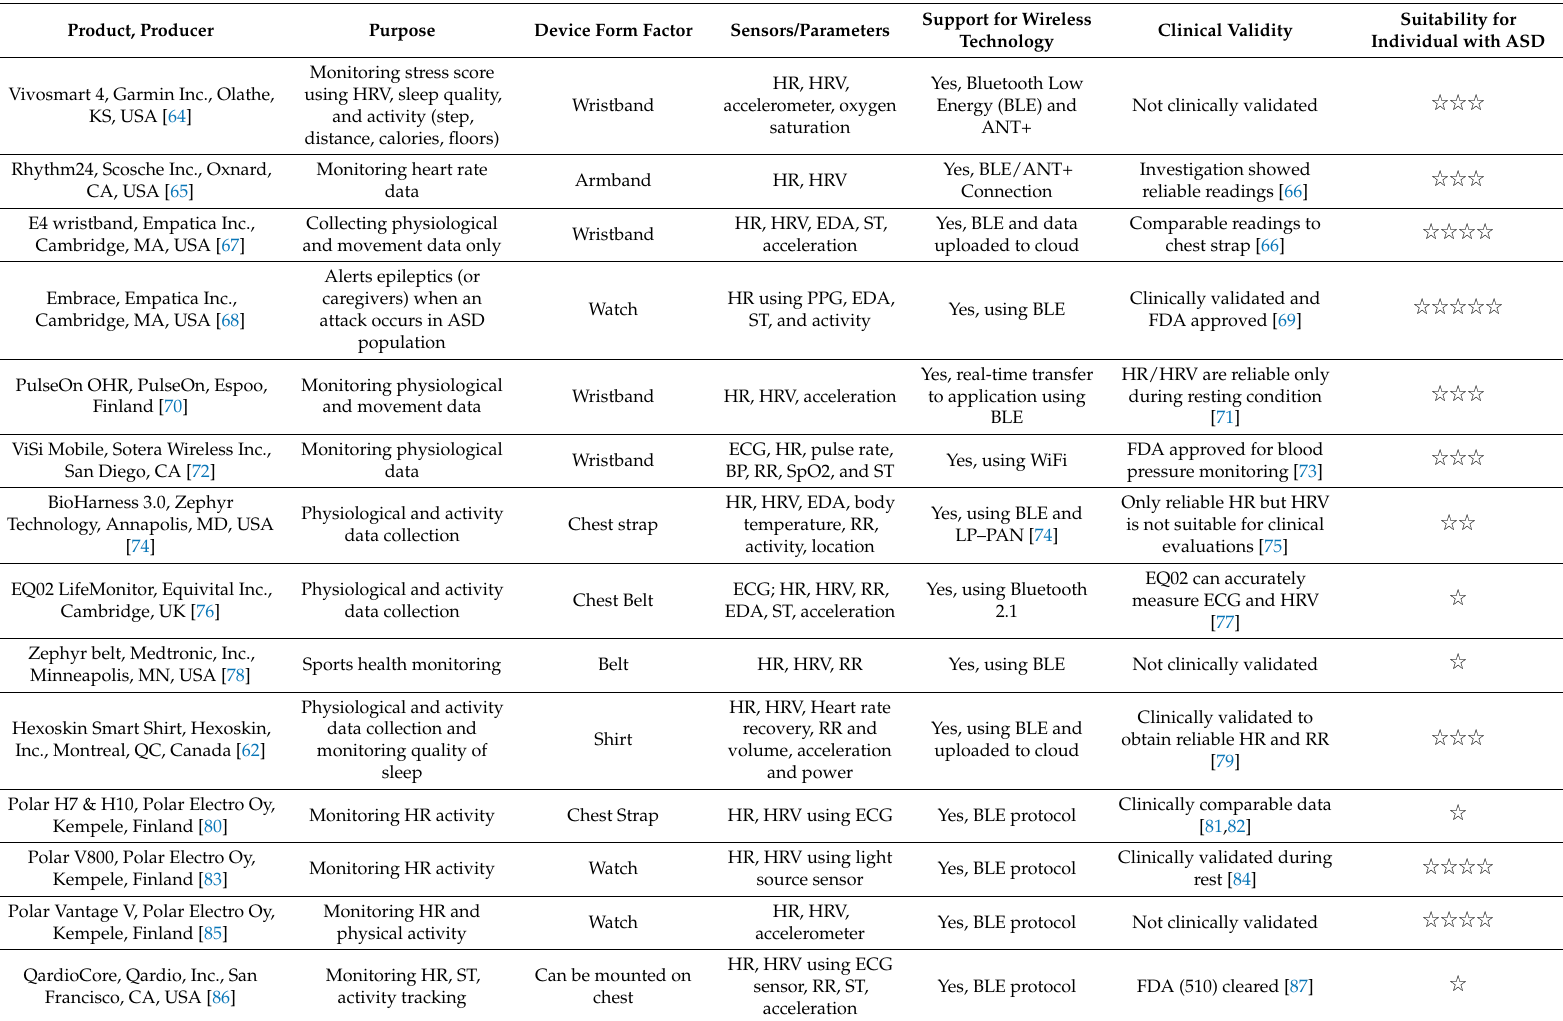
Table 1. Comparison of commercial physiological and emotional monitoring